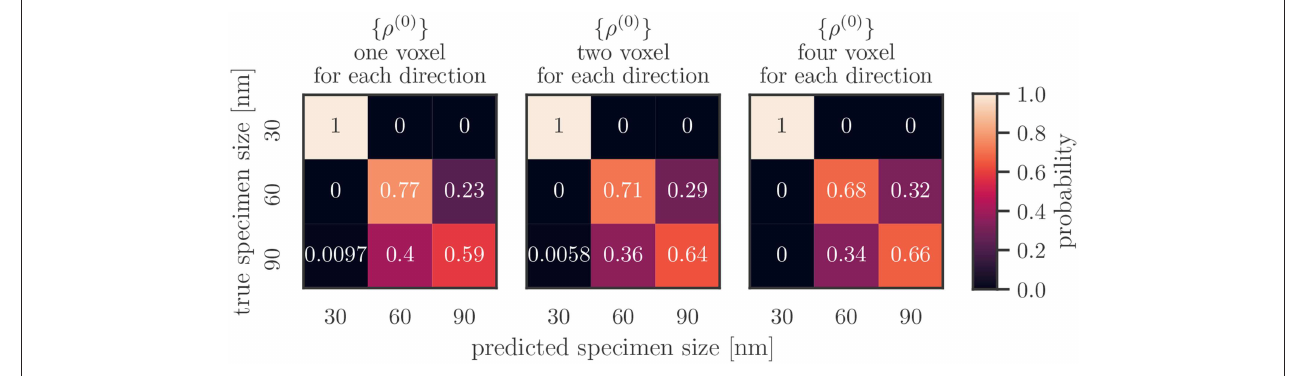
ρ (0) as feature into { }